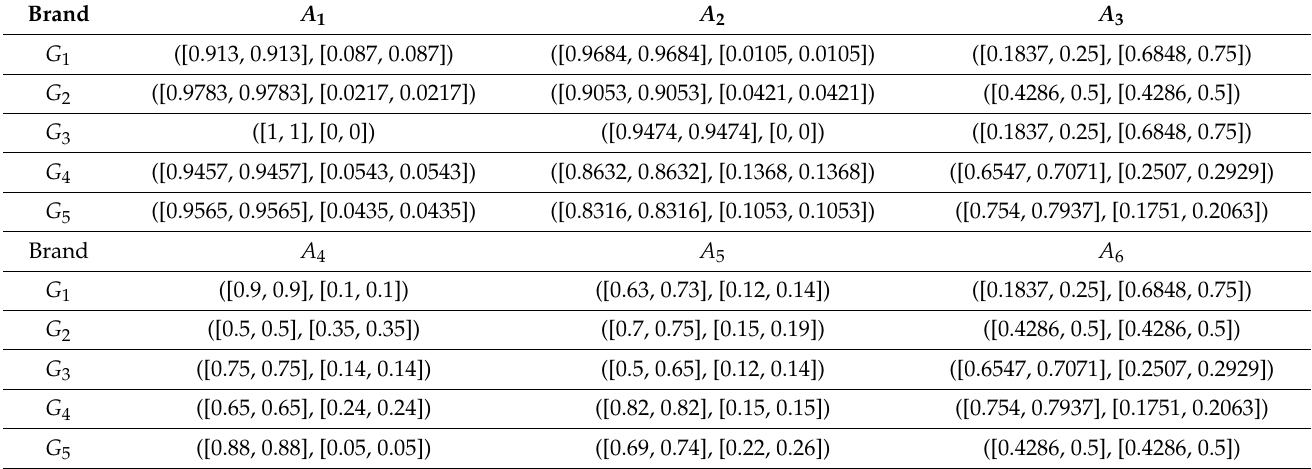
Table 9. The transformed evaluation matrix of expert D 3 .